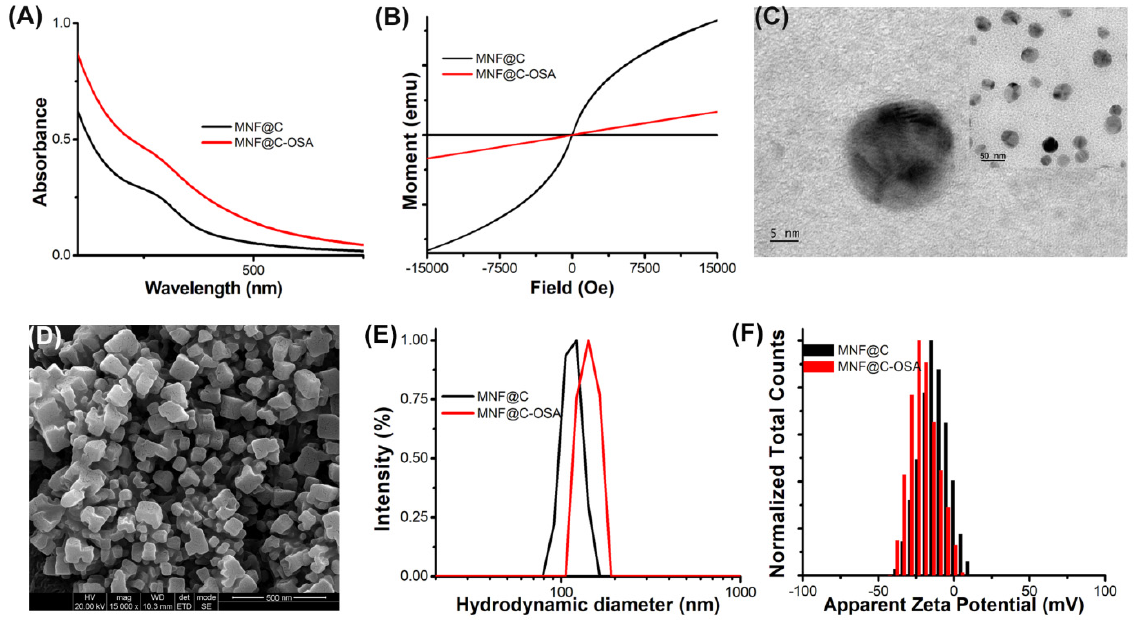
Figure 2. ( A ) Absorption spectra of MNF@Cs and MNF@C-OSAs. ( B ) Vibrating-sample magnetometry of MNF@Cs and MNF@C-OSAs. ( C ) Transmission electron microscope image of MNF@Cs; the inset shows a 50 nm scale. ( D ) Scanning electron microscope image of MNF@C-OSAs. ( E ). Colloidal particle size distribution of MNF@Cs and MNF@C-OSAs. ( F ) Measured zeta potentials of MNF@Cs and